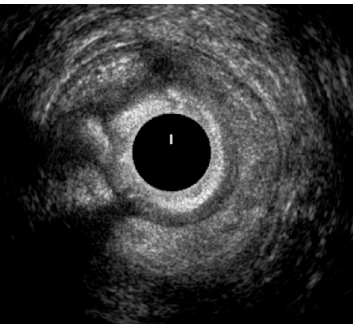
Figure 3. Integrity of the internal and external anal sphincters. Three fistulas identified, all with setons in place: transphincteric fistula at the anterior quadrant at 12 o’clock, right quadrant at 9 o’clock and posterior quadrant at 7 o’clock.